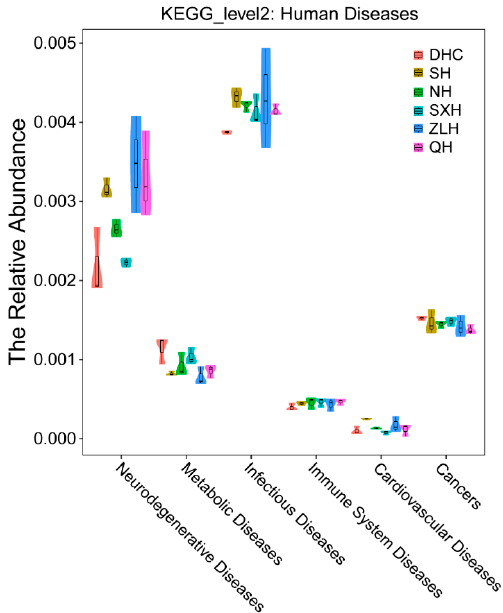
Figure 4. PICRUSt prediction of related human disease caused by DHC, SH, NH, SXH, ZLH and QH groups based on the Kyoto Encyclopedia of Genes and Genomes (KEGG) PATHWAY Database.